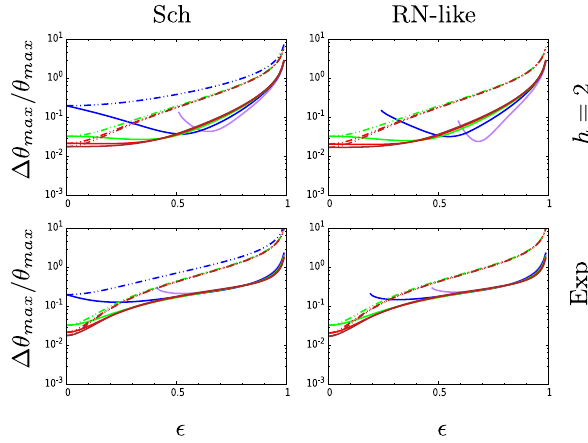
Fig. 32 Relative error in θ max ( | θ max , a − θ max | /θ max ) as a function of the frequency ratio (cid:11) for r = R . q ∗ = − ( 0 . 50 M ) 2 . The purple, blue, green, red and brown lines correspond respectively to R = 3 . 5, 4, 5, 6 and 7. The continuous lines were obtained from Eq. (5.2) (with plasma correction) while the dashed lines were obtained from Eq. (5.1) (without plasma correction)